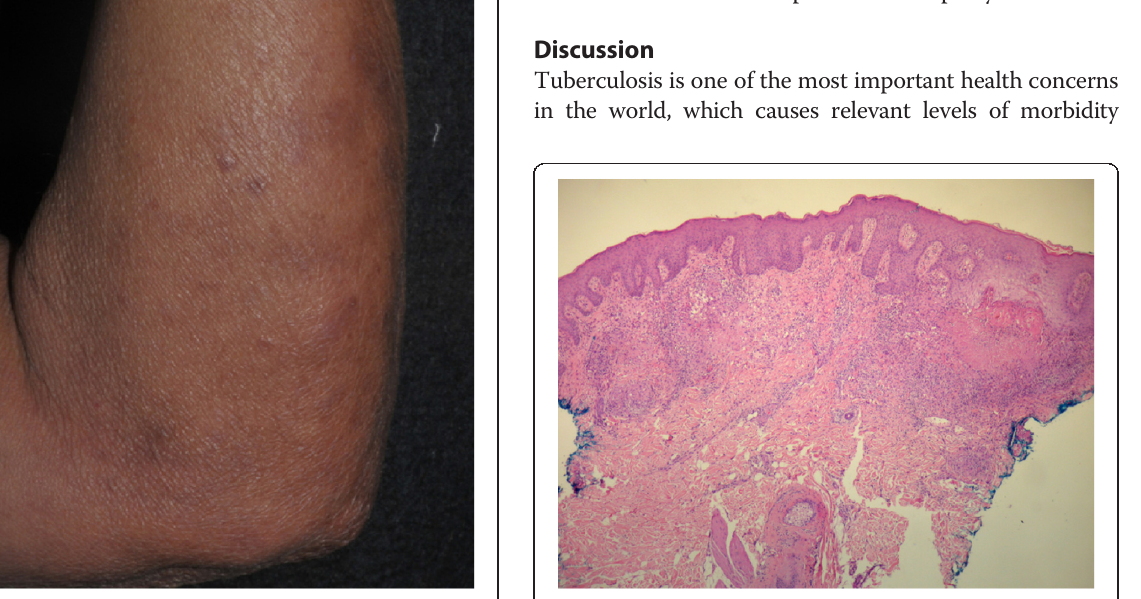
Figure 3 Histopathological exam of the perianal ulcer showing a dense histiocytic infiltrate and central caseous